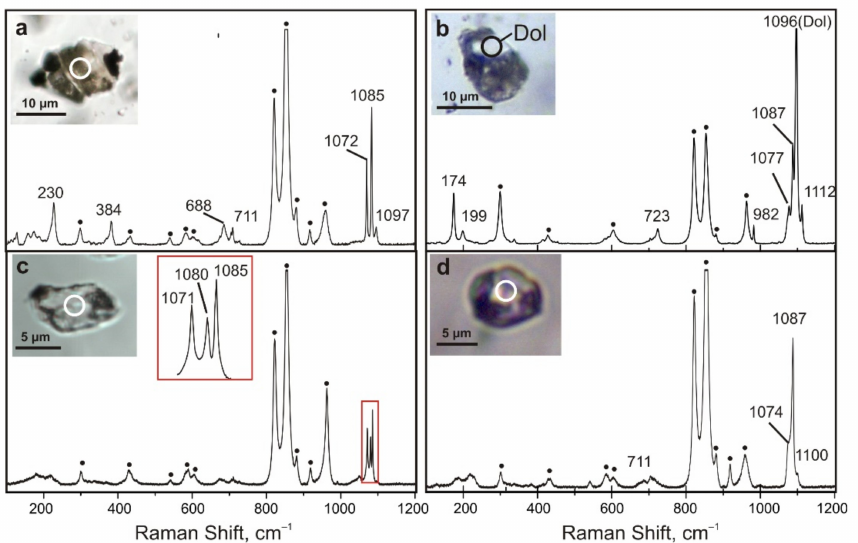
Figure 8. Raman spectra of inclusions containing many carbonate phases. Strong bands in the region of 1071–1112 cm − 1 correspond to the vibrations of the [CO 3 ]-group: bands at 1071–1077 cm − 1 belong to alkaline carbonates ( a – d ), lines at 1086–1087 cm − 1 may belong to calcite ( a – d ), bands at 1096–1097 cm − 1 are assigned to dolomite ( a , b ), the band at 1080 cm − 1 probably belongs to natrite ( c ). The line at 982 cm − 1 corresponds to the vibration of the [SO 4 ]-group ( b ). The circles on the inclusion photos show the analyzed areas. Lines of host olivine on the Raman spectra are tagged by black dots under the lines of